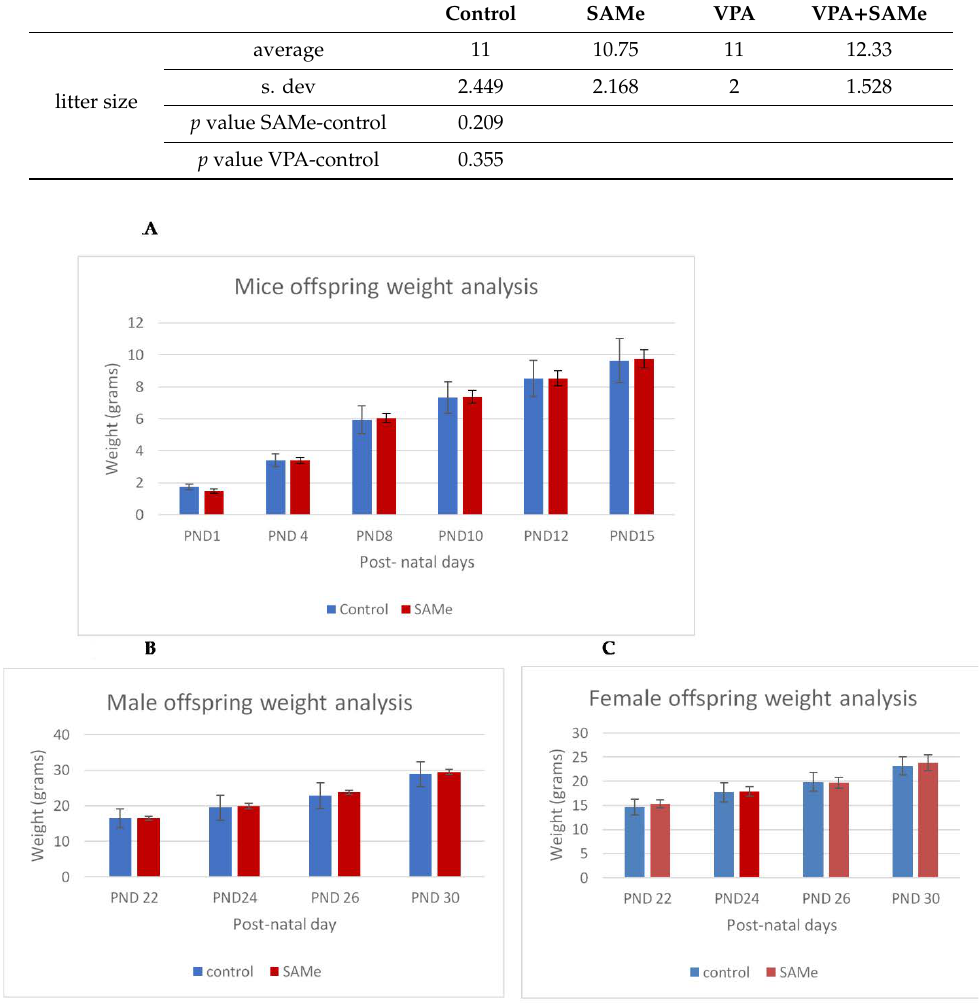
Figure 1. Figure 1 A – C . Control versus S-adenosyl methionine ( SAMe) offspring weight gain between post-natal day (PND)1 and PND30. Weight analysis of control versus SAMe pups between PND1 and PND15 days. Males and females combined. The number of pups in each group was 18. ( B , C ): Figures 1B and 1C: Weight analysis of control vs. SAMe offspring between PND22 and PND30. 1 B represents males and 1 C represents females. Number of animals in each group: 6–9 in males, 9–12 in females.